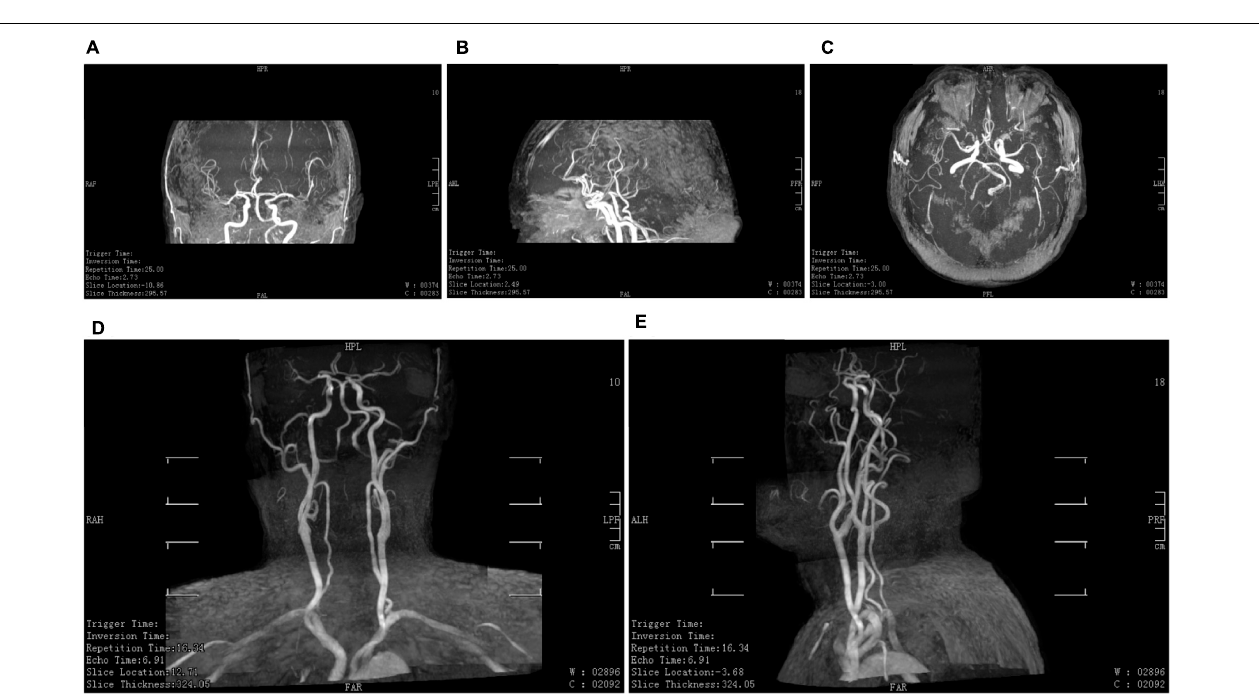
FIGURE 2 | Cerebral vessels in 2011. (A–C) Head computed tomography angiography findings in 2011. His cerebral vessels ran normally, and there was no stenosis of the lumen.